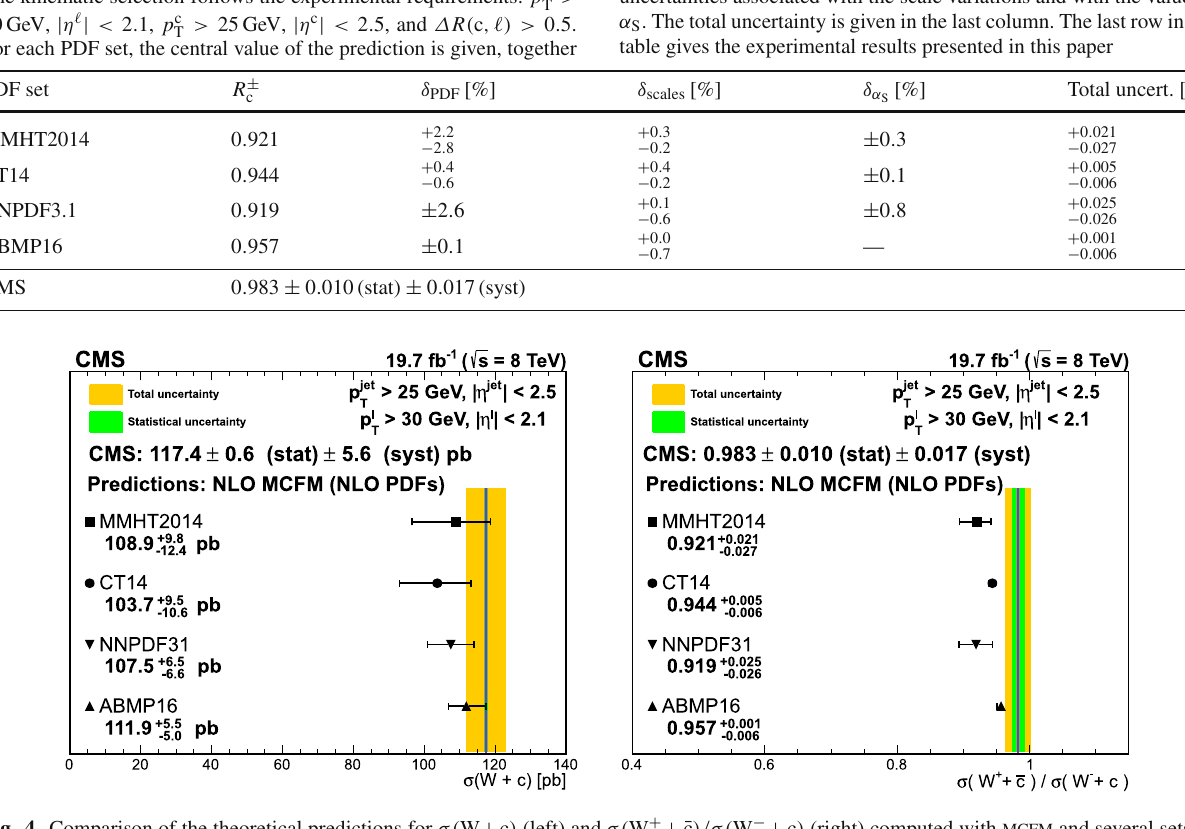
Table12 Theoreticalpredictionsfor R ± c calculatedwith mcfm atNLO. The kinematic selection follows the experimental requirements: p (cid:3)